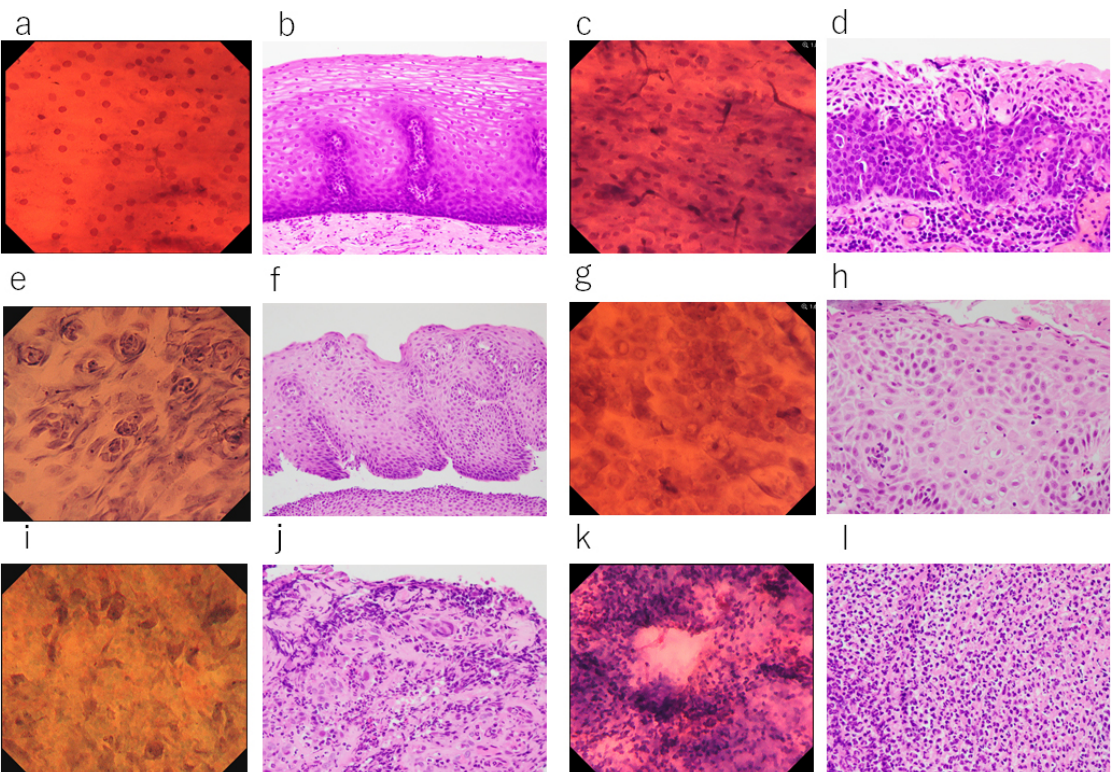
Figure 3. Comparison between EC observations and histological findings: ( a ) EC image of normal esophageal mucosa (Type 1, toluidine blue stain, × 900). ( b ) Histological section of normal esophageal mucosa (HE, × 400). ( c ) EC image of esophageal squamous cell carcinoma. Increased nuclear density, nuclear abnormality, and nuclear enlargement are evident (Type 3, toluidine blue stain, × 900). ( d ) Histological section of esophageal squamous cell carcinoma (histological section of the same lesion as ( c )). Atypical cells have replaced the entire epithelial layer (HE, × 400). ( e ) EC image of esophagitis. Non-malignant cells are circularly arranged around the epithelial papilla (non-malignant EC feature 1, toluidine blue stain, × 500). ( f ) Histological section of the same area as ( e ). Elongation of the epithelial papillae is evident just beyond the epithelial surface (HE, × 200). ( g ) EC image of regenerating squamous epithelium. Weakly staining nuclei and prominent nucleoli are evident. The cytoplasm is darkly stained and intercellular space dilation is clearly recognized (non-malignant EC feature 2, toluidine blue stain, × 900). ( h ) Histology of the same area as ( g ). Prominent nucleoli are evident within the nuclei, with clear intercellular borders (HE, × 400). ( i ) EC image of esophageal erosion. Increased nuclear density, nuclei of variable size, and spindle-shaped enlarged nuclei are evident (non-malignant EC feature 3, toluidine blue stain, × 900). ( j ) Histological section of the same area as ( i ). Inflammatory cell infiltration and stromal fibroblasts are observed as nuclear atypia (HE, × 400). ( k ) EC image showing the white coat of radiation esophagitis. Dense aggregation of small inflammatory cells is evident (non-malignant EC feature 4, toluidine blue stain, × 900). ( l ) Histopathological image of the same area as ( k ), showing dense aggregation of inflammatory cells (HE, ×400).